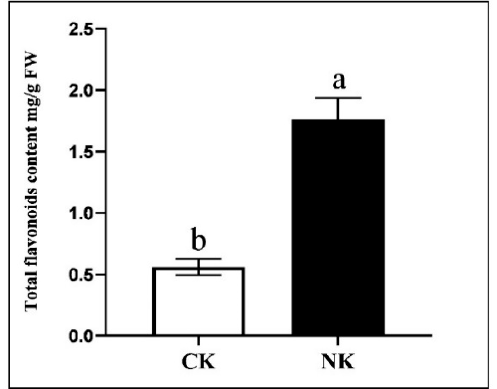
Figure 7. The total flavonoid content of water dropwort under soil culture (CK) and Yamasaki nutrient solution (NK). Different letters indicate a significant difference in the total flavonoid content of water dropwort between different treatments, at the 5% level. Error bars show the standard deviation (SD) of three biological replicates.